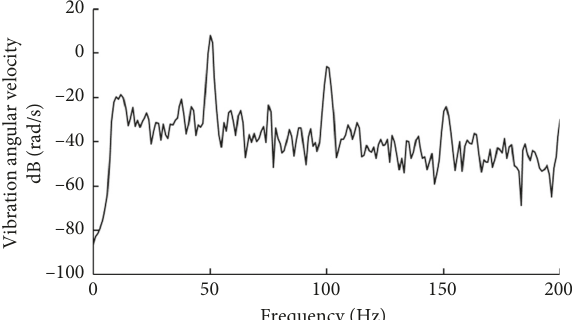
Figure 25: Frequency response function of rear suspension.